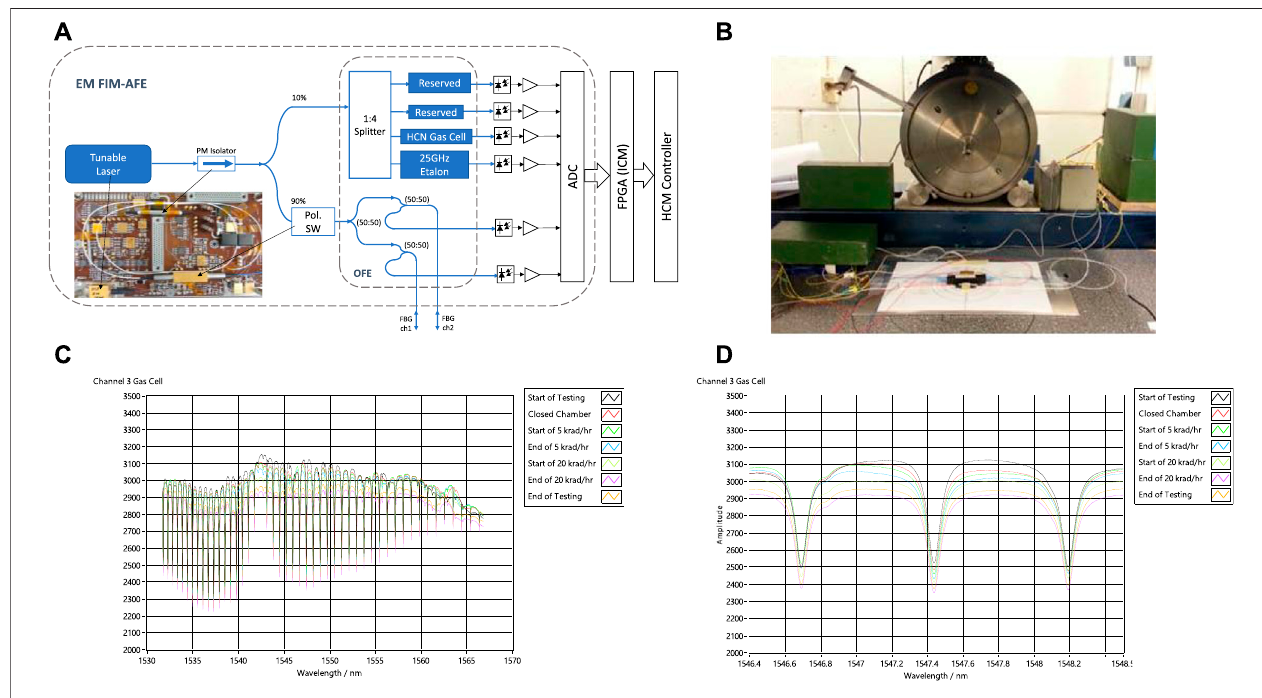
FIGURE 10 | (A) CWL shift with 25 Mrad at a dose rate of 420 rad/h, (B) CWL shift at 300 krad total dose (420 rad/h vs. 4.1 rad/h).